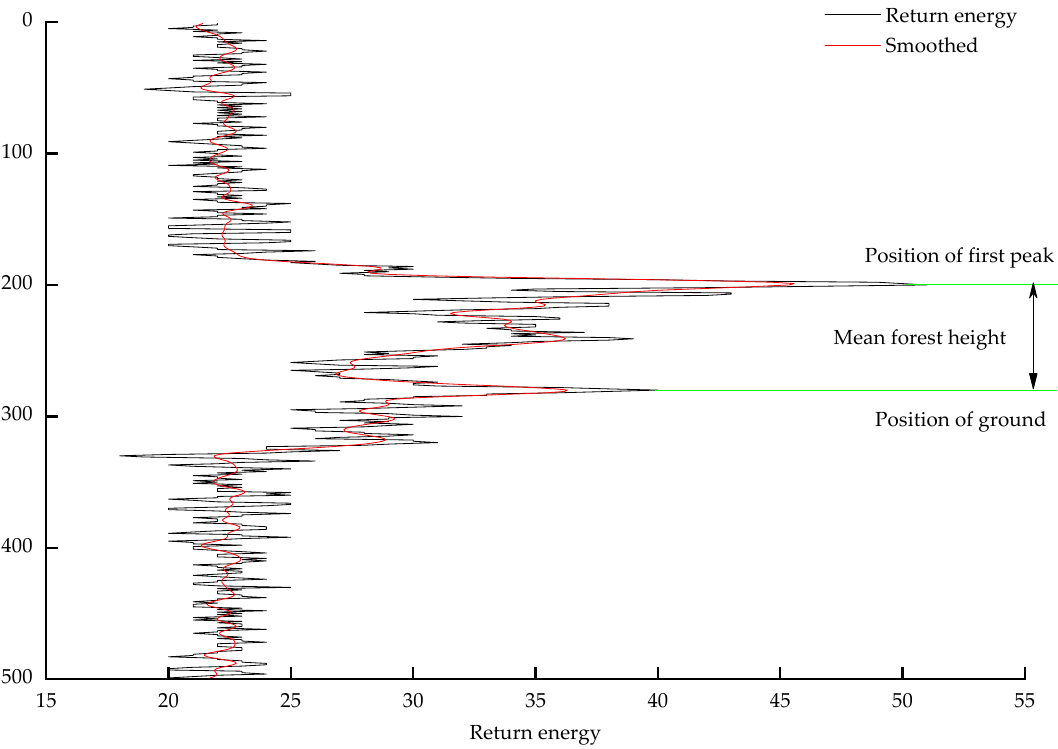
Figure 9. Estimation of mean forest height. The black line connects each of the 500 ns-level reflectance observations, and the red line is a filtered (fast Fourier transformation) representation of the same information.